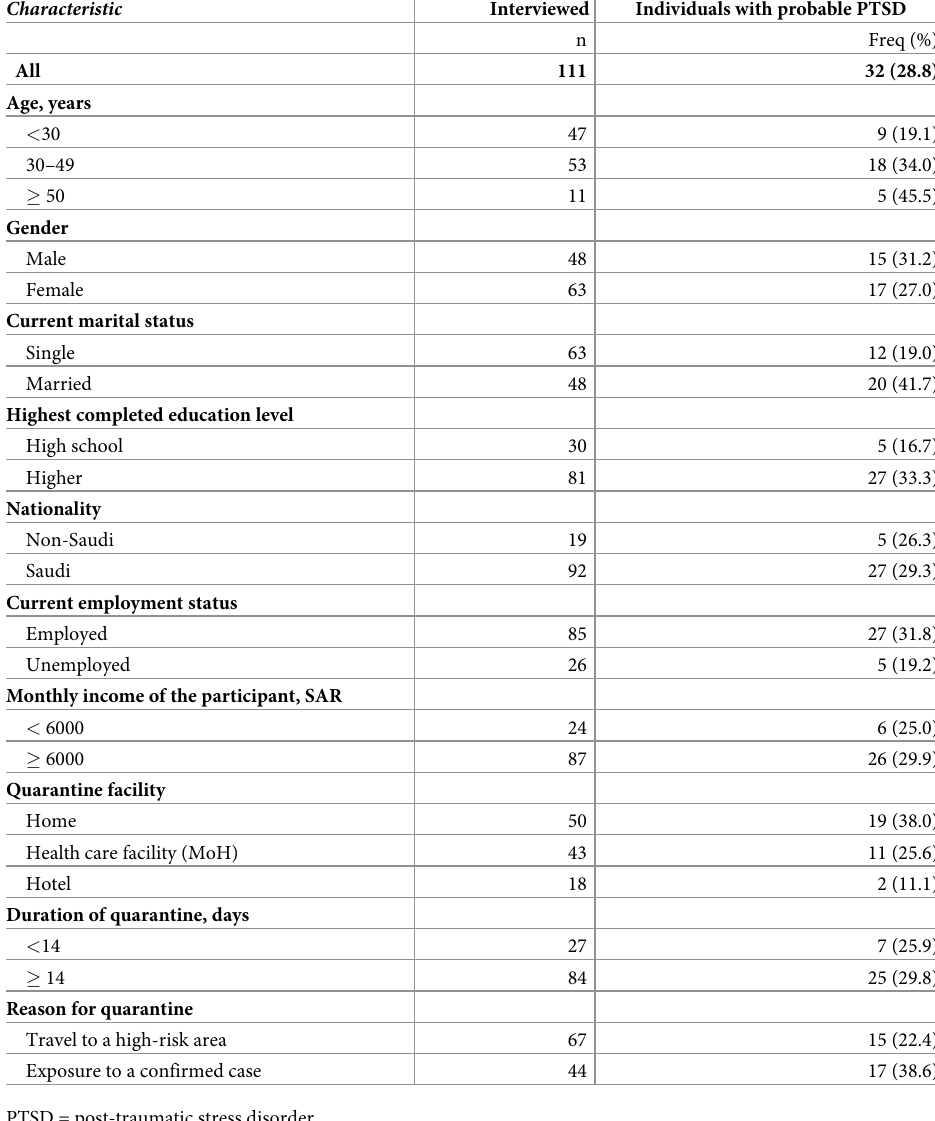
Table 2. Frequency of probable post traumatic stress disorder � –overall and across